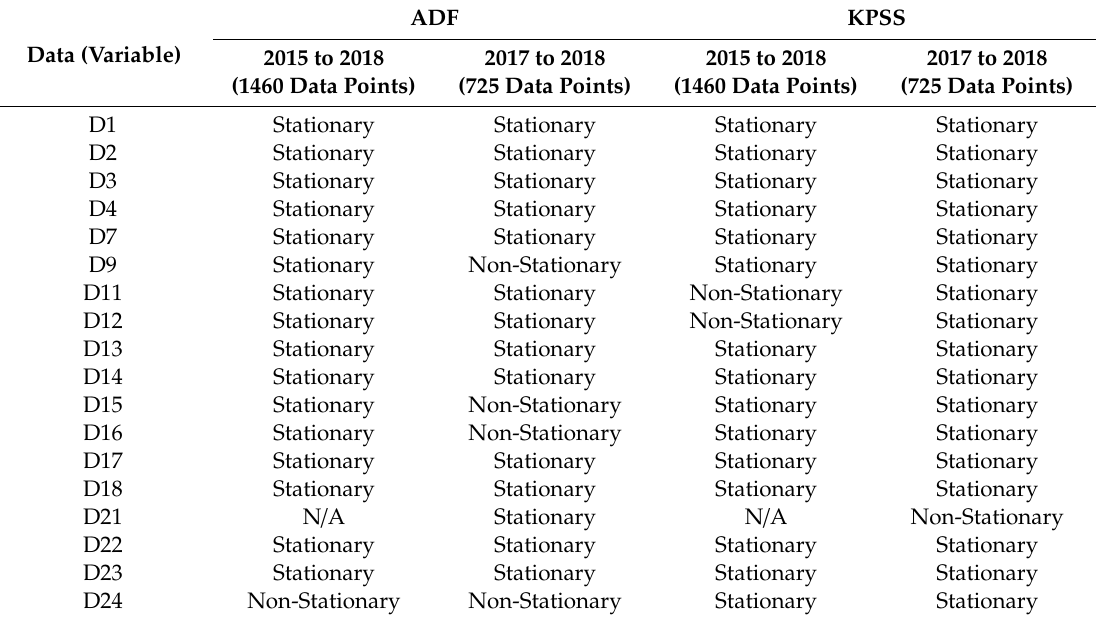
Table 5. Augmented Dickey-Fuller (ADF) and Kwiatkowski–Phillips–Schmidt–Shin (KPSS) stationarity test results.